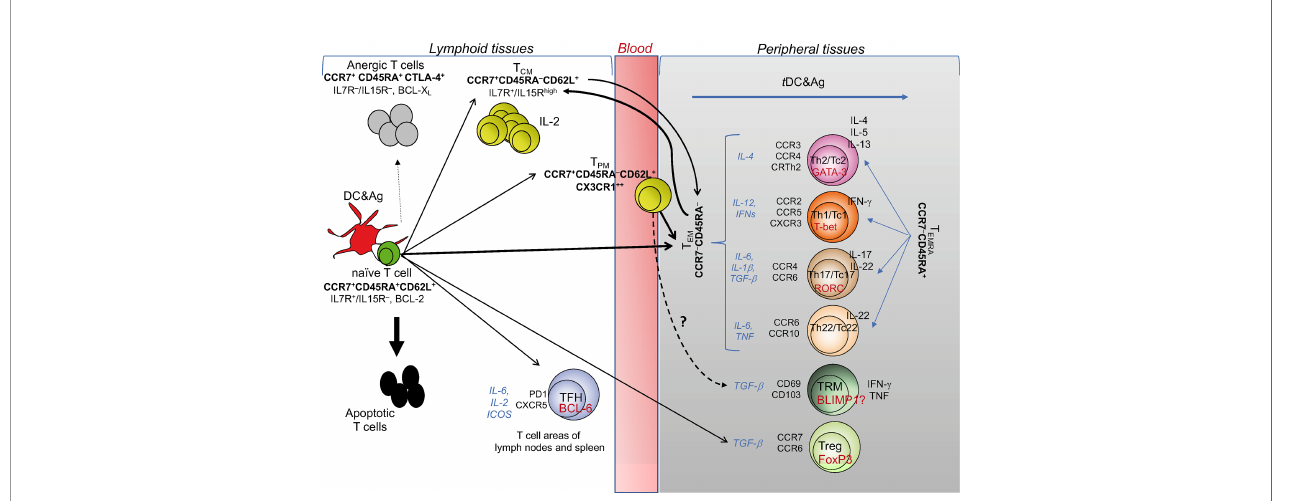
FIGURE 1 | T cell diversity and memory pathways. This cartoon depicts the “ one cell, multiple fates ” hypothesis proposing that a single naïve (CD4 + or CD8 + ) T cell undergoes multiple fates, according to the strength of signals 1 and 2 received by pAPCs: suboptimal signals (e.g., signal 1 without signal 2) causes T cell anergy; excessive signals (as in the case of response to superantigens, such as some bacterial toxins) cause T cell apoptosis; optimal signal strength induces typically and functionally distinct T EM , T CM , and T PM cells with the same speci fi city. T CM cells can also derive from T EM : upon performing effector functions, the majority of T EM dye, while a minority is saved and generates T CM . T CM cells acquiring the chemokine lymphoid homing receptors (indicated in bold under the T CM subset) continuously recirculate via the bloodstream to lymphoid organs, and promptly generate secondary responses. CX3CR1 + T PM cells migrate from blood to tissue to lymph nodes, proliferate in a higher fashion than the T CM population, display the ability to perform cytotoxic function, and survey non-lymphoid tissues. The differentiation into the various T EM subsets (Th1, Th2, Th17, Th22, or the cytotoxic T [Tc] cell counterparts) is conditioned by the microenvironmental cytokine milieu (indicated by the cytokines in italics), in which the response takes place. Under these conditions, each of the T EM subsets activates its own speci fi c transcription master regulator (indicated in red within each T EM subset) contributing to establish the gene expression patterns correlated with speci fi c cytokine immune-phenotypes (indicated to the right of each T EM subset), and expresses its own speci fi c pattern of in fl amed tissue homing receptors (indicated to the left of each T EM subset). Upon migration into the speci fi c in fl amed tissues, each type of T EM subset is ready to differentiate into terminally-differentiated effector cells (T EMRA ) promptly performing the functions for which they are programmed (Th2, Th1, Th17, etc.), following contact with tissue-resident ( t )DCs presenting the speci fi c antigens derived from various type of pathogens: that is, the helminths preferentially will condition the Th2, the intracellular pathogens the Th1, the fungi the Th17 differentiation, etc. TFH cell differentiation is regulated by IL-6, IL-2, inducible costimulator receptor (ICOS): if the chemokine receptor CXCR5 is expressed, they will migrate to the border of the B cell follicle and help B cell differentiation, whereas, in the presence of the related cell signals, they differentiate into Th1-, Th2-, or Th17-like cells, exit the lymphoid tissue and traf fi c to the site of infection or in fl ammation. Similar cell diversi fi cation occurs upon optimal activation of CD8 + T cells that also acquire the cytotoxicity function (Tc: T cytotoxic cell). T RM and Treg pro fi les are conditioned by the antigens they meet directly in the tissues and lymphoid organs, respectively, in the presence of TGF- b